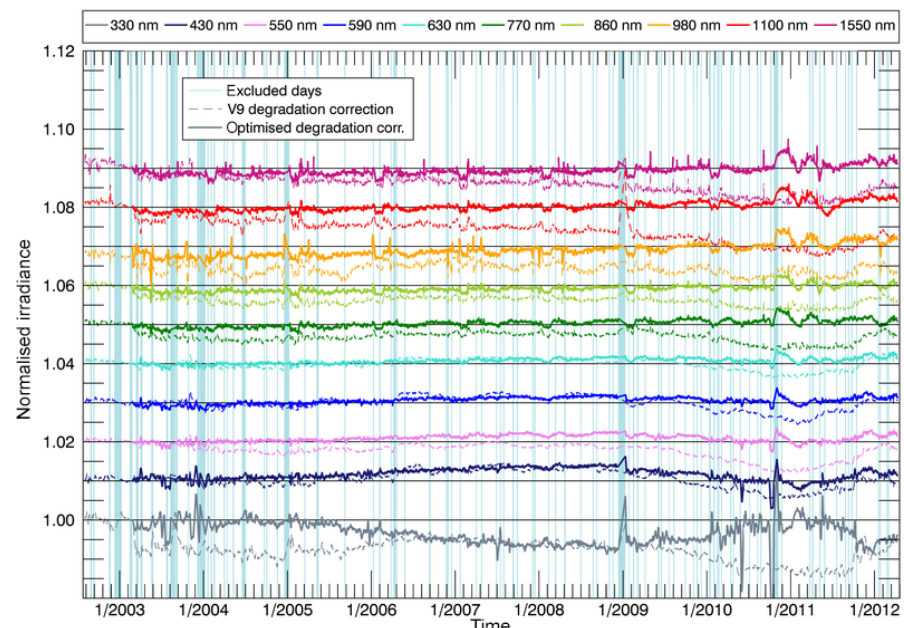
Figure 9. SCIAMACHY SSI time series for selected wavelengths. Each time series is shifted vertically by 0.01 for better visibility and normalised to the reference day of degradation correction (27 February 2003). The dashed lines show the SCIAMACHY SSI with ESA V9.01 calibration; solid lines show the recalibrated SCIAMACHY SSI from this work. Vertical bars indicate days or extended periods with maintenance activities (e.g. ice decontamination periods), platform and instrument anomalies, and orbit control manoeuvres when data are considered highly